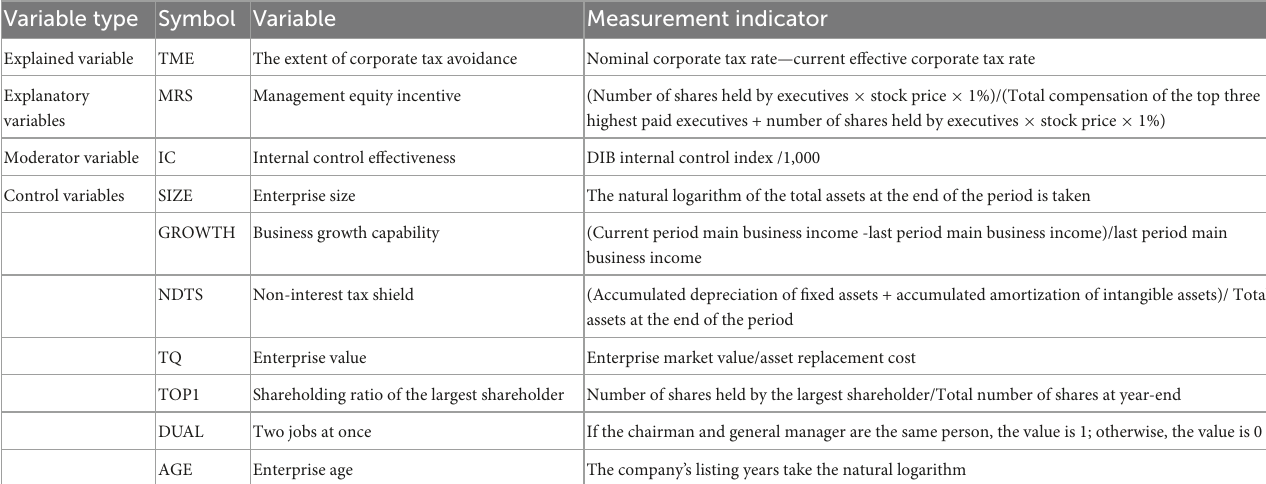
TABLE 2 Variable definition. Variable type Symbol Variable Measurement indicator Explained variable